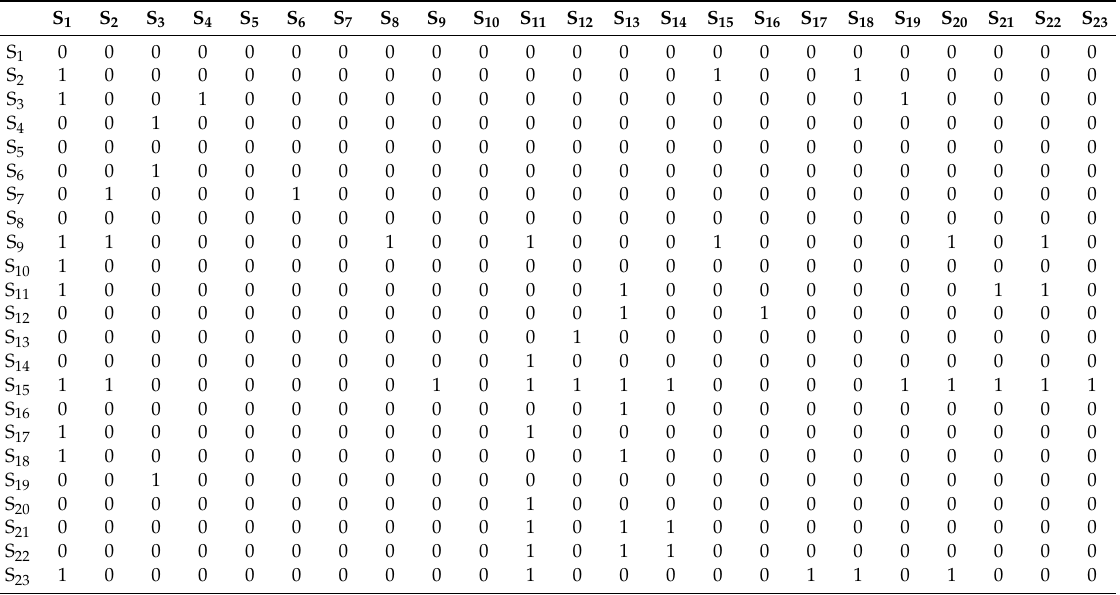
Table 2. The adjacency matrix of super-gentrification dynamic